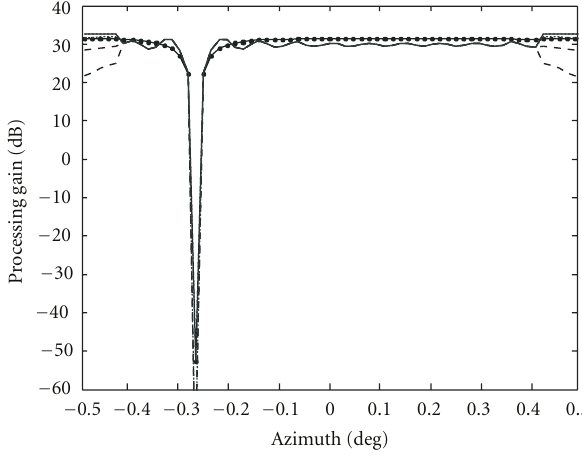
Figure 5: Sensitivity to switching time error ( t 0 = T p / 2). •− Reduced STAP with 128 adaptive degrees of freedom ( N p = 64; N B = 2). −− MTR-STAP single receiver system with 64 pulses ( M = 12) using (cid:10) t 0 = 0,0 . 2 T p ,0 . 8 T p (incorrect values), − (cid:10) t 0 = 0 . 5 T p (true